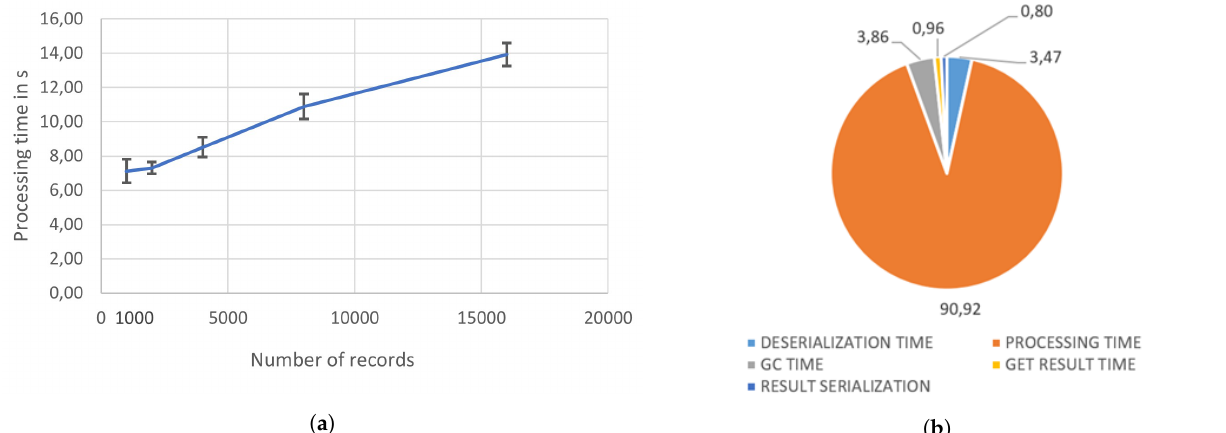
Figure 4. Vehicular processing pipeline performance. The experiments were carried out in a testbed comprising 4 VMs—1 driver and 3 workers—each equipped with 8 vCores, 32 GB vRAM and 150 GB data SSD support. ( a ) Overall processing time under varying number of ingress records. ( b ) Processing time decomposition for the 15,000 record